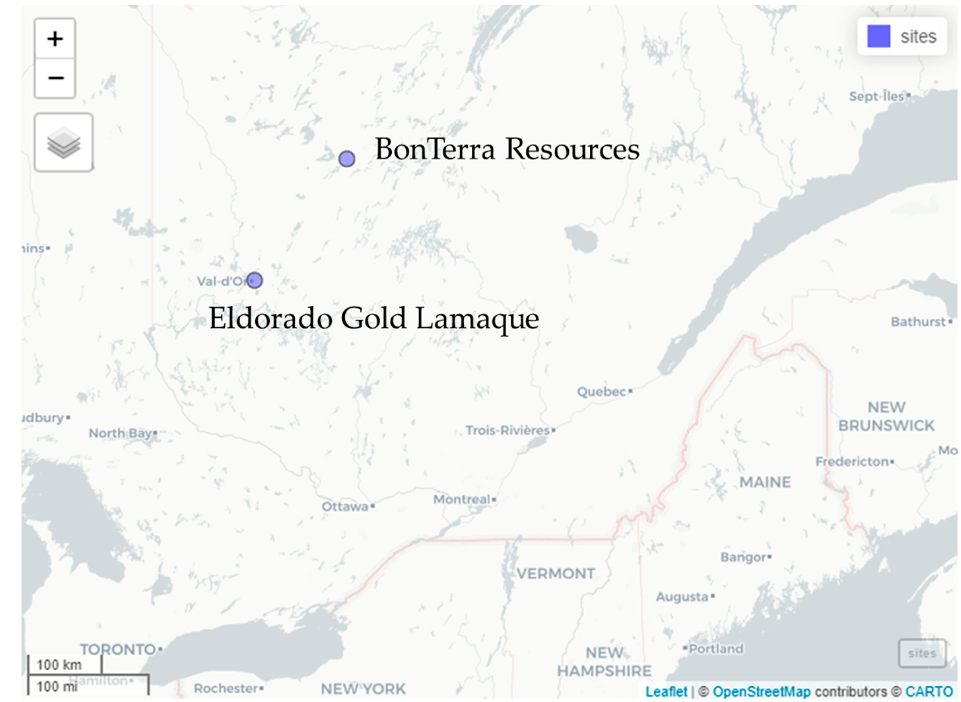
Figure 2. The site location at the gold mine in Quebec, Canada.